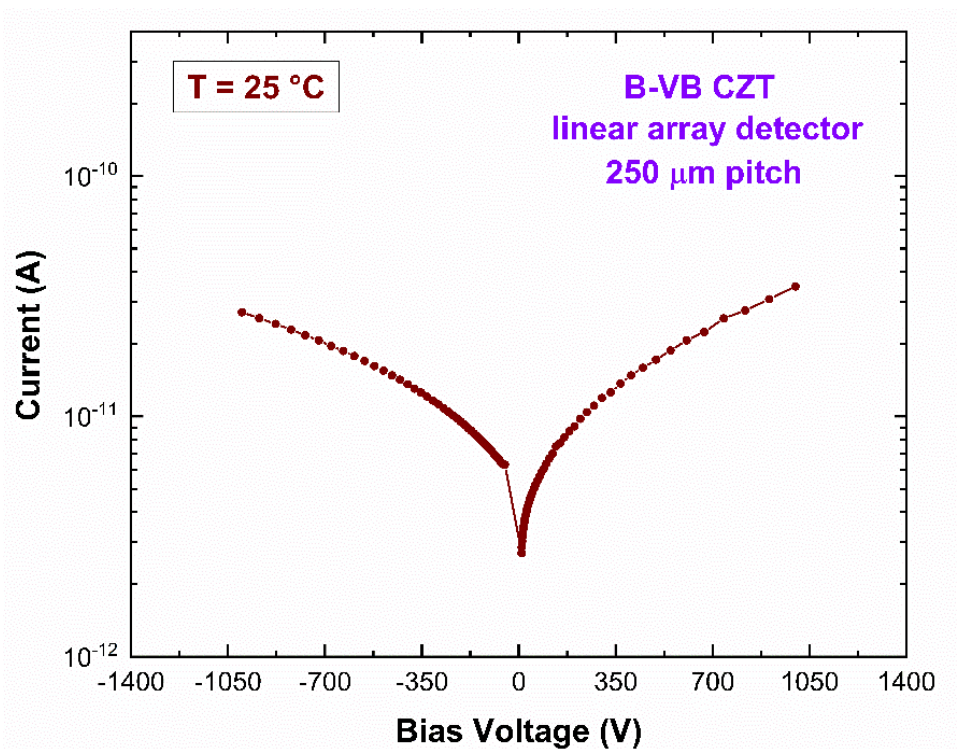
Figure 2. The current-voltage characteristics of a tested pixel of the CZT linear array detector. Low leakage current < 30 pA at − 1000 V (9000 V/cm) was measured; the symmetry of the curve confirms the quasi-ohmic nature of the gold-electroless contacts.